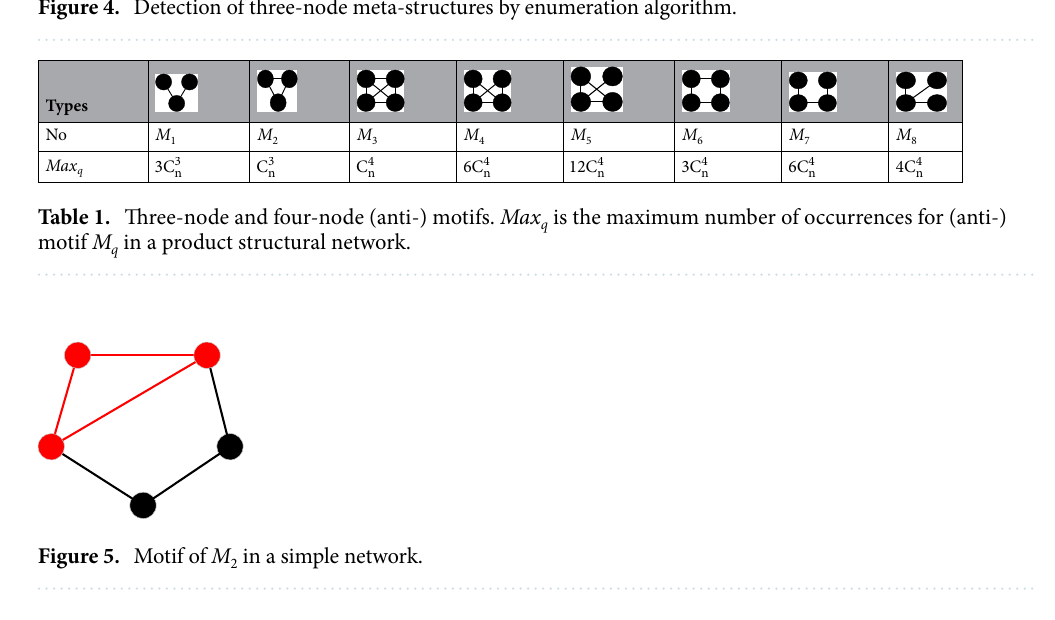
Figure 4. Detection of three-node meta-structures by enumeration algorithm.